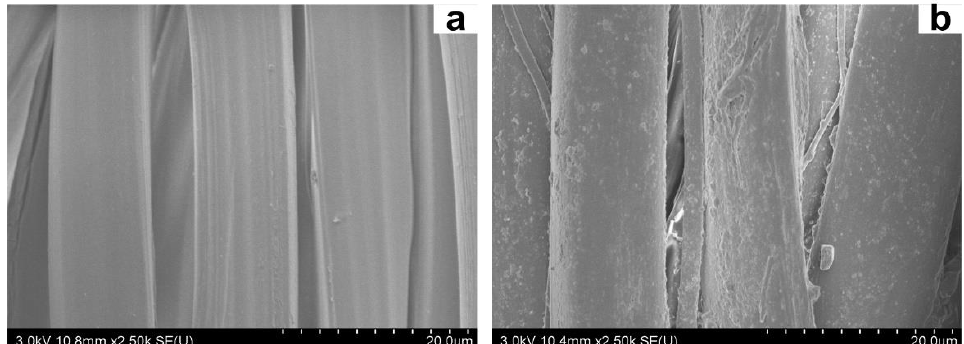
Figure 6. SEM micrographs of the undyed ( a ) and dyed ( b ) silk fabrics.